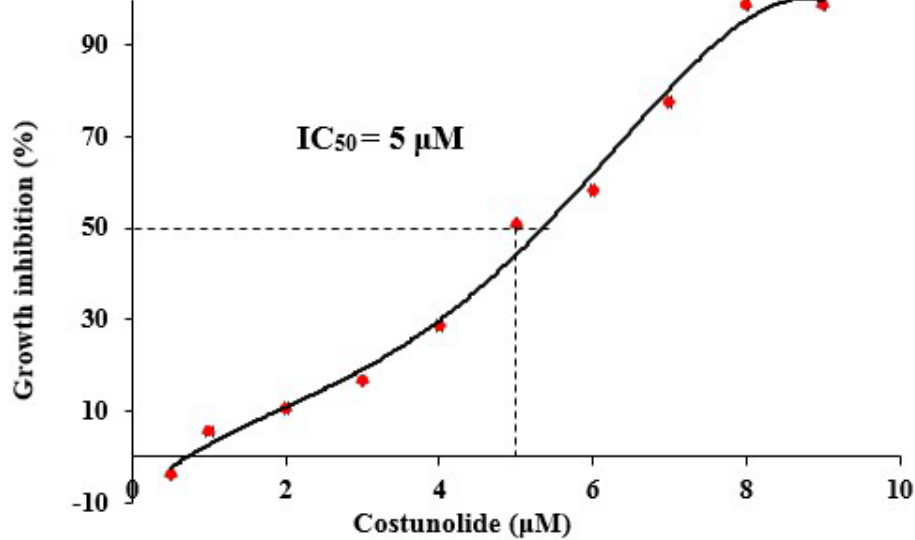
Figure 3. Growth inhibition (%) of Jurkat cells by costunolide and calculation of IC 50 value. Inhibitory effect of varying costunolide concentrations (0.5–9 μM) on Jurkat cells growth was monitored. Dotted line represents IC 50 value (5 μM).